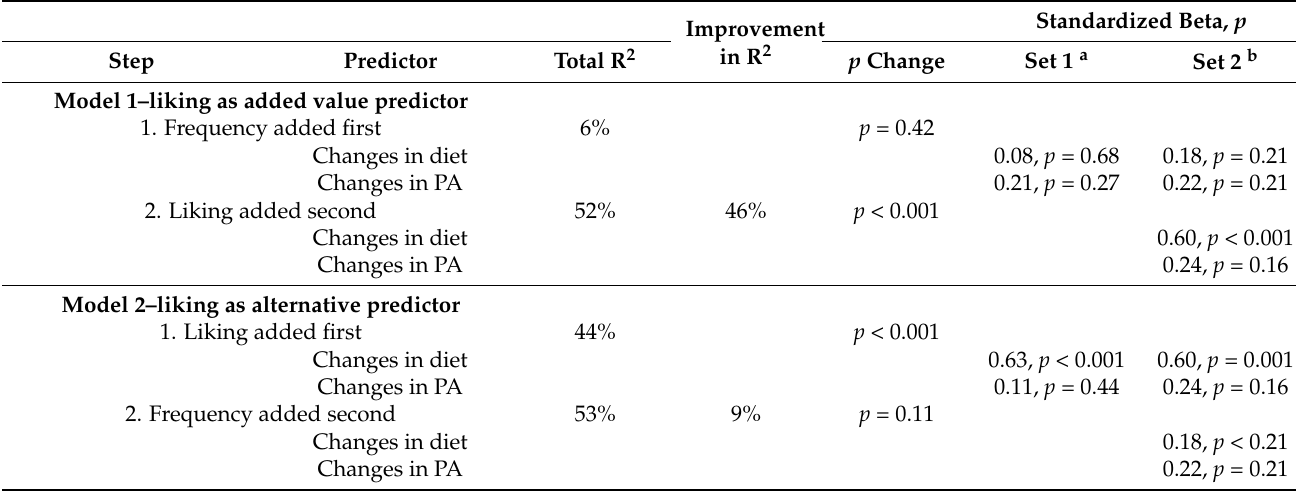
Table 4. Relative contributions of changes in liking- and frequency-based indexes on percent weight change from pre- to post-intervention in women using nested regression